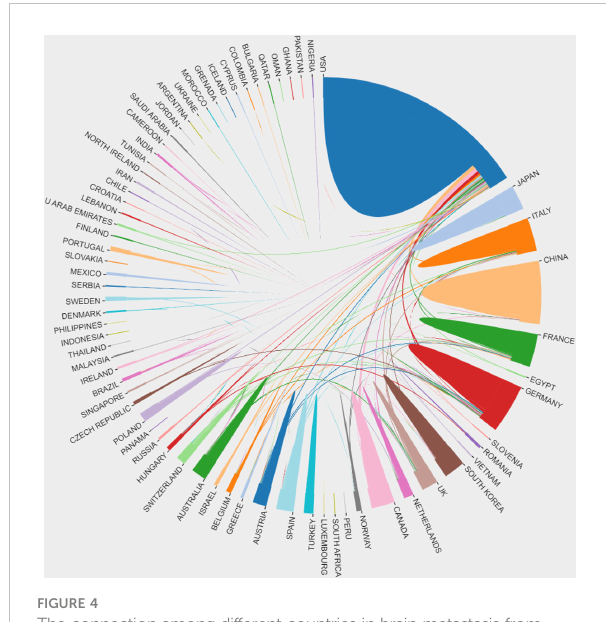
FIGURE 4 The connection among different countries in brain metastasis from breast cancer. Each country was represented by a fragment on the outer part of the circle. The area of the fragment is proportional to the number of publications of the correspondent country and the size of the arc to the strength of cooperation between two